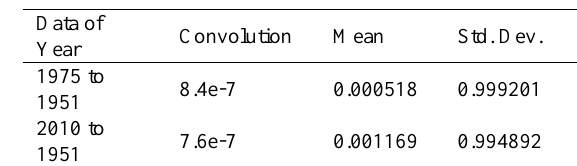
Table 4. The registration from 1975 to 1951 and 2010 to 1951 [units: